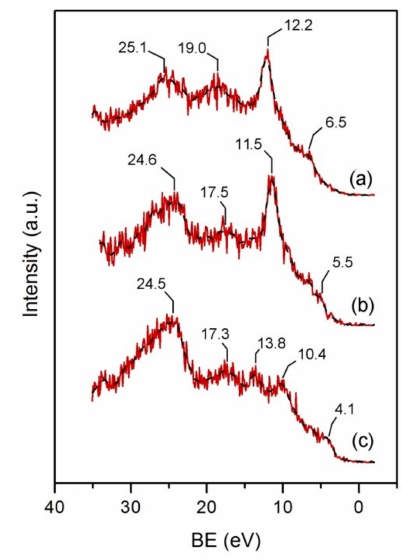
Figure 6. Valence-band X-ray photoelectron spectra of ( a ) untreated ACC and hybrid PAni-ACC composites synthesized after ( b ) 20 min and ( c ) 120 min of galvanostatic